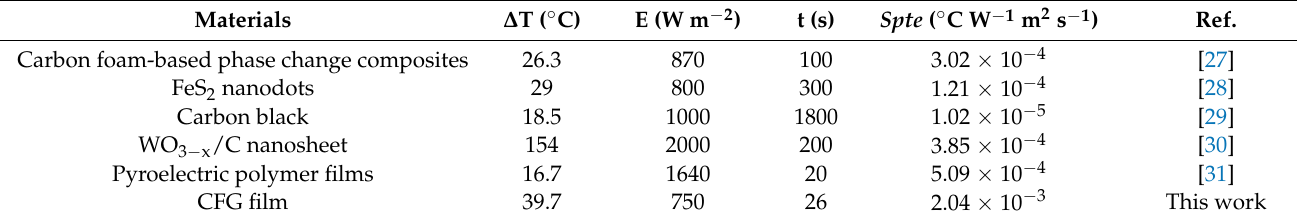
Table 3. Comparison of the Spte of some typical photo-thermal materials and the CFG film.